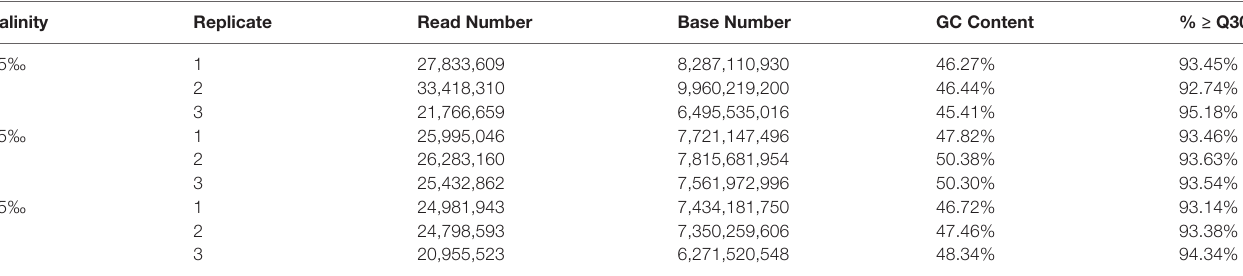
the number of mononucleotides, dinucleotides, trinucleotides, tetranucleotides, pentanucleotides and hexanucleotides were 4,124, 4,261, 2,767, 162, 7 and 4, respectively.